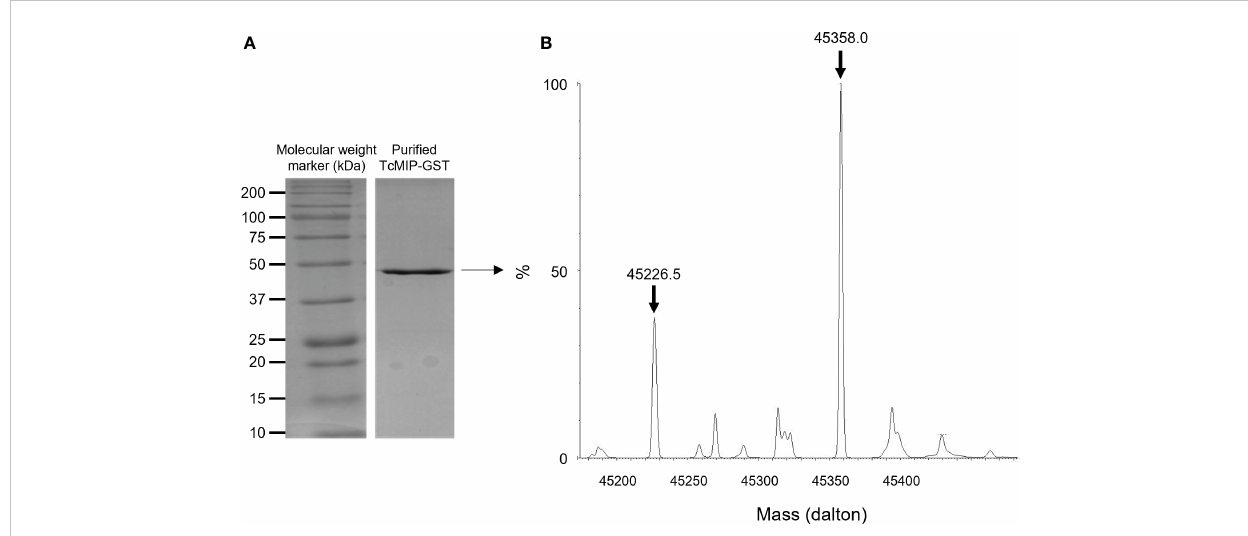
FIGURE 1 Analysis of the puri fi ed recombinant TcMIP fused to GST. (A) SDS-Page analysis showing the puri fi ed recombinant protein TcMIP fused to GST (rTcMIP). (B) Deconvoluted mass spectrum of the puri fi ed rTcMIP analyzed by Q-Tof mass spectrometry. The spectrum shows two major peaks: one at 45358 Da corresponding to the mass of the fused recombinant protein supplemented with one H+ cation, and one at 45226.5 Da corresponding to the loss of a